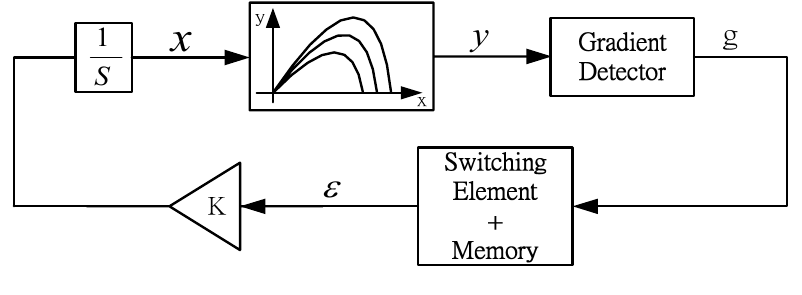
Figure 8. A block diagram of an ESC